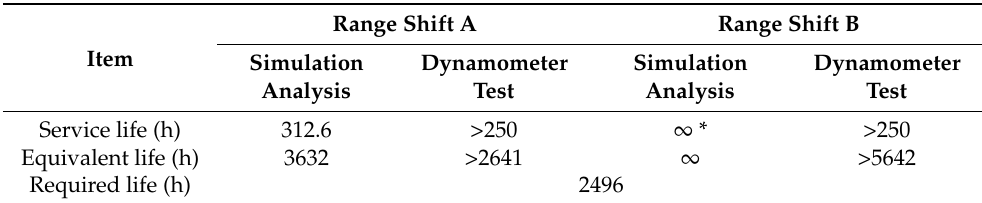
Table 8. Comparisons of life for the changed range shift gears between the simulation analysis and dynamometer test. Range Shift A Range Shift B Item Simulation Dynamometer Simulation Dynamometer Analysis Test Analysis Test Service life (h) 312.6 >250 ∞ *